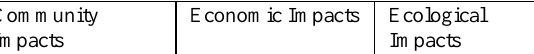
Table 1: Impacts of uncontrolled Urban